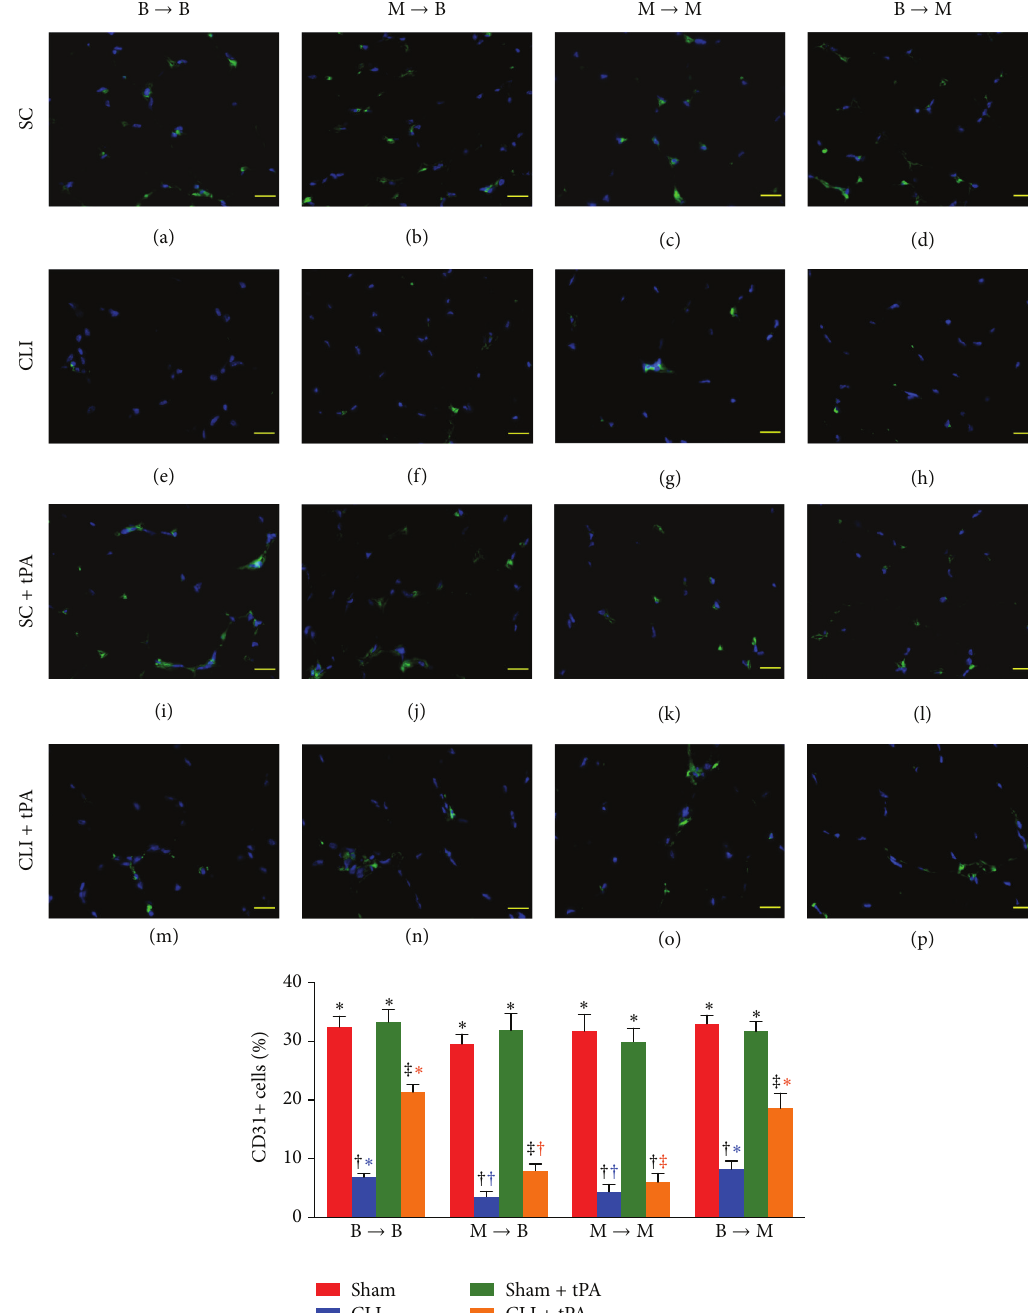
Figure 7: Immunofluorescent (IF) microscopic findings (400x) of CD31+ cells in ischemic quadriceps at day 14 after critical limb ischemia (CLI) induction. (a–p) IF microscopic findings of CD31+ cells in ischemic area in four treatment conditions of four groups. (1) Statistical analysis for subgroups of each group. (1) In B → B group, subgroups with different black symbols ( ∗ , † , and ‡ ), 𝑝 < 0.05 . (2) In M → B group, subgroups with different black symbols ( ∗ , † , and ‡ ), 𝑝 < 0.05 . (3) In M → M group, subgroups with different black symbols ( ∗ , † ), 𝑝 < 0.05 . (4) In B → M group, subgroups with different black symbols ( ∗ , † , and ‡ ), 𝑝 < 0.05 . (2) Statistical analysis for group comparison with respective treatment condition. (1) In SC subgroup (red bar chart), 𝑝 > 0.1 . (2) In CLI subgroup (blue bar chart), groups with different blue symbols ( ∗ , † ), 𝑝 < 0.05 . (3) In SC + tPA subgroup (green bar chart), 𝑝 > 0.1 . (4) In CLI + tPA subgroup (orange bar chart), groups with different orange symbols ( ∗ , † , and ‡ ), 𝑝 < 0.05 . All statistical analyses were performed by one-way ANOVA followed by Bonferroni multiple comparison post hoc test. SC = sham control; tPA = tissue plasminogen activator. 𝑛 = 6 for each